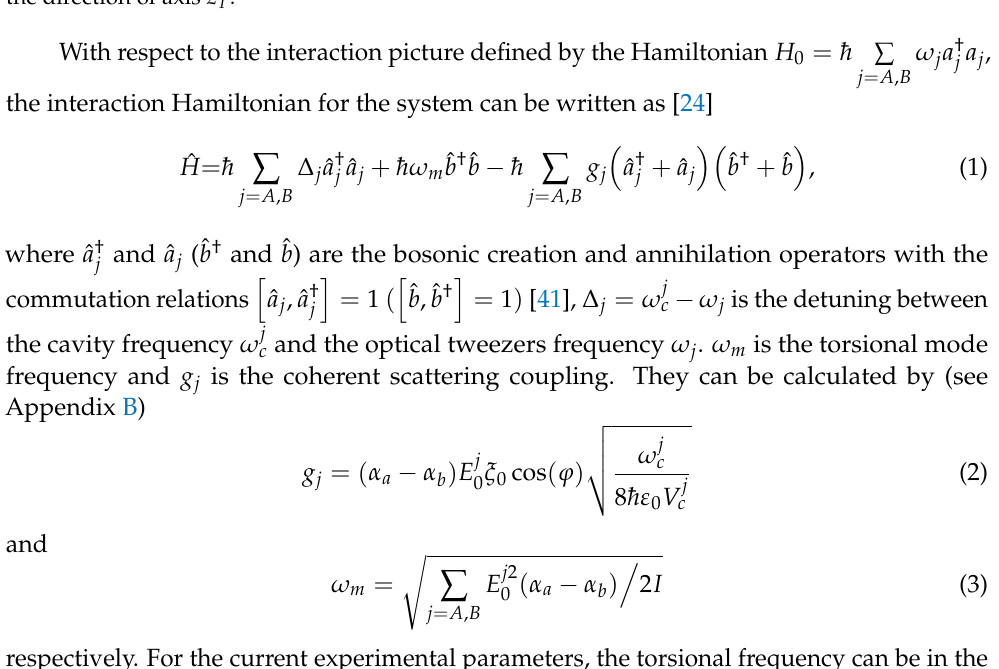
Figure 1. ( a ) Schematic diagram of the levitated optomechanical system. The nano-ellipsoid is placed into a bichromatic cavity and optically levitated by the dual tweezers with two frequencies ω A and ω B , and amplitudes E A and E B , respectively. Two cavity modes ˆ a † the scattering photons with the decay rates κ A and κ B . ( b ) The orientation of the nano-ellipsoid { x } rotates under the tweezers coordinate { x E , y E , z E between the cavity coordinate axis x C and tweezers coordinate axis x T . Tweezers propagate along the direction of axis z T